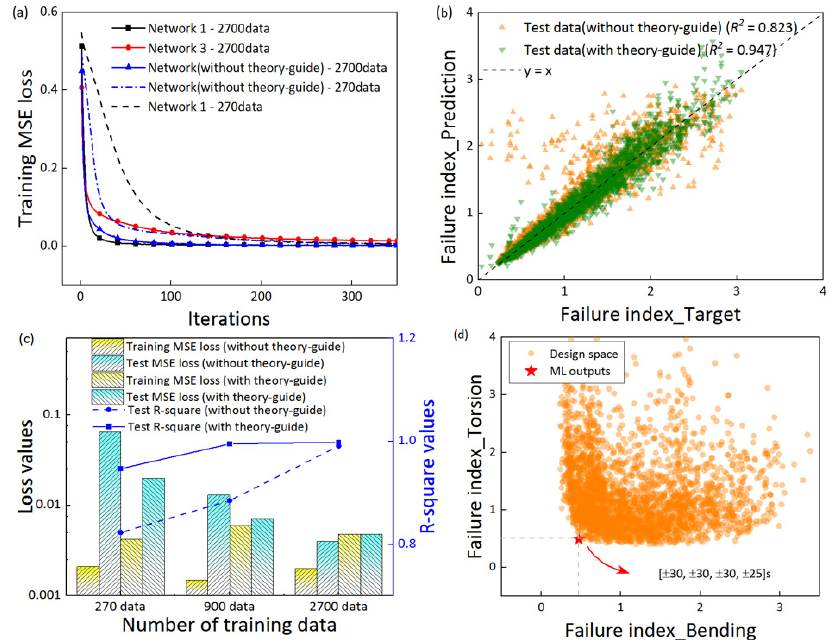
Figure 4. A comparison between the models with and without theory-guides under different amounts of training data. ( a ) Mean squared error on the 2700 and 270 training data samples with increasing iterations. ( b ) The regression performance on the test data samples when models were trained with only 270 data samples. ( c ) The loss values and R 2 comparisons of the models trained with the 270, 900, and 2700 data samples. ( d ) The GA module searched for the optimal solution for 3000 sets of failure index solutions.